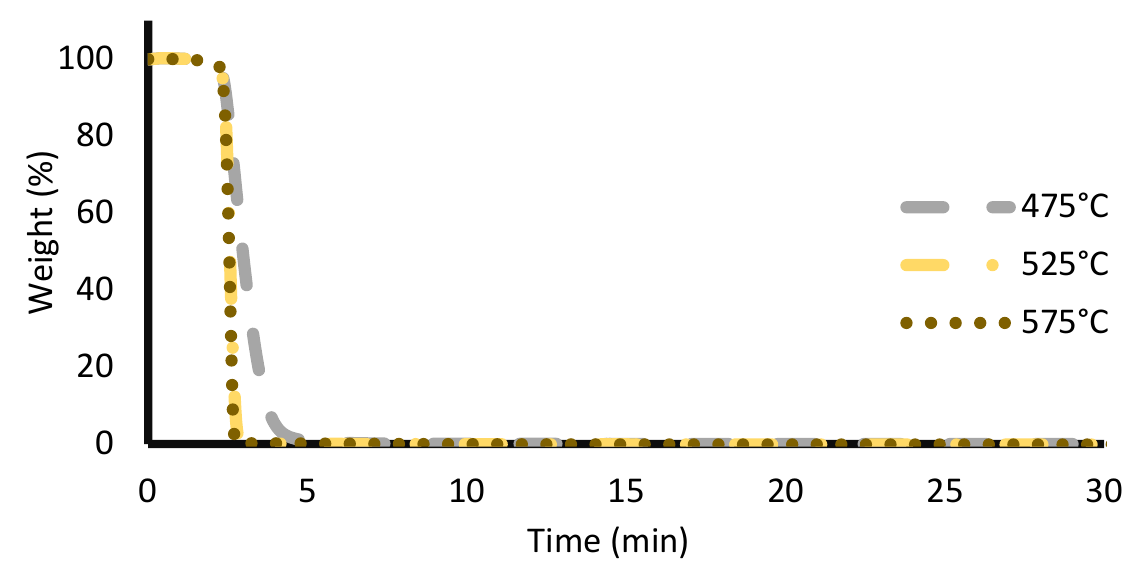
Figure 3. Isothermal TGA at 50 °C increments.